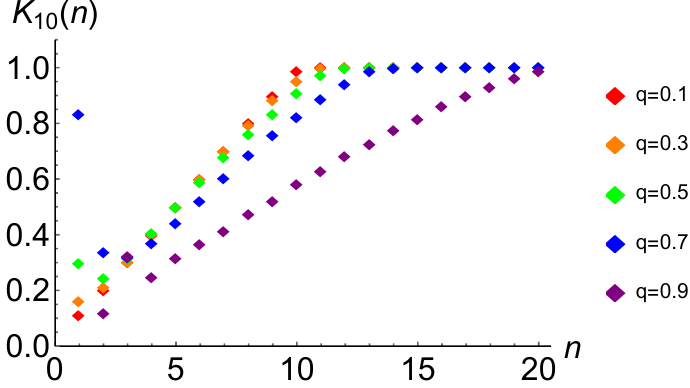
Figure 1: The SFF for N “ 10 and various values of q .